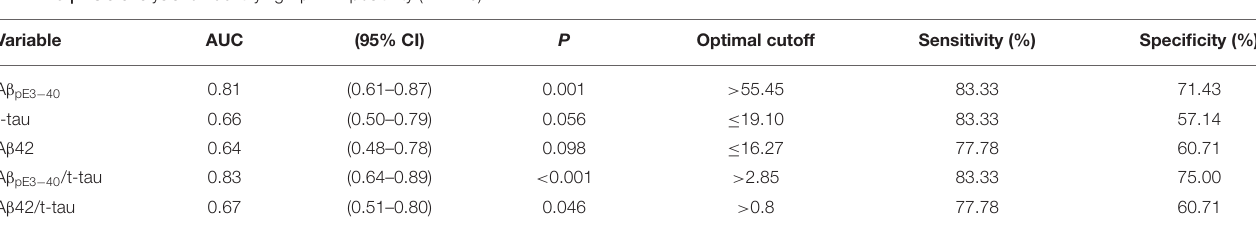
TABLE 3 | ROC analysis for identifying A β PET positivity ( N =